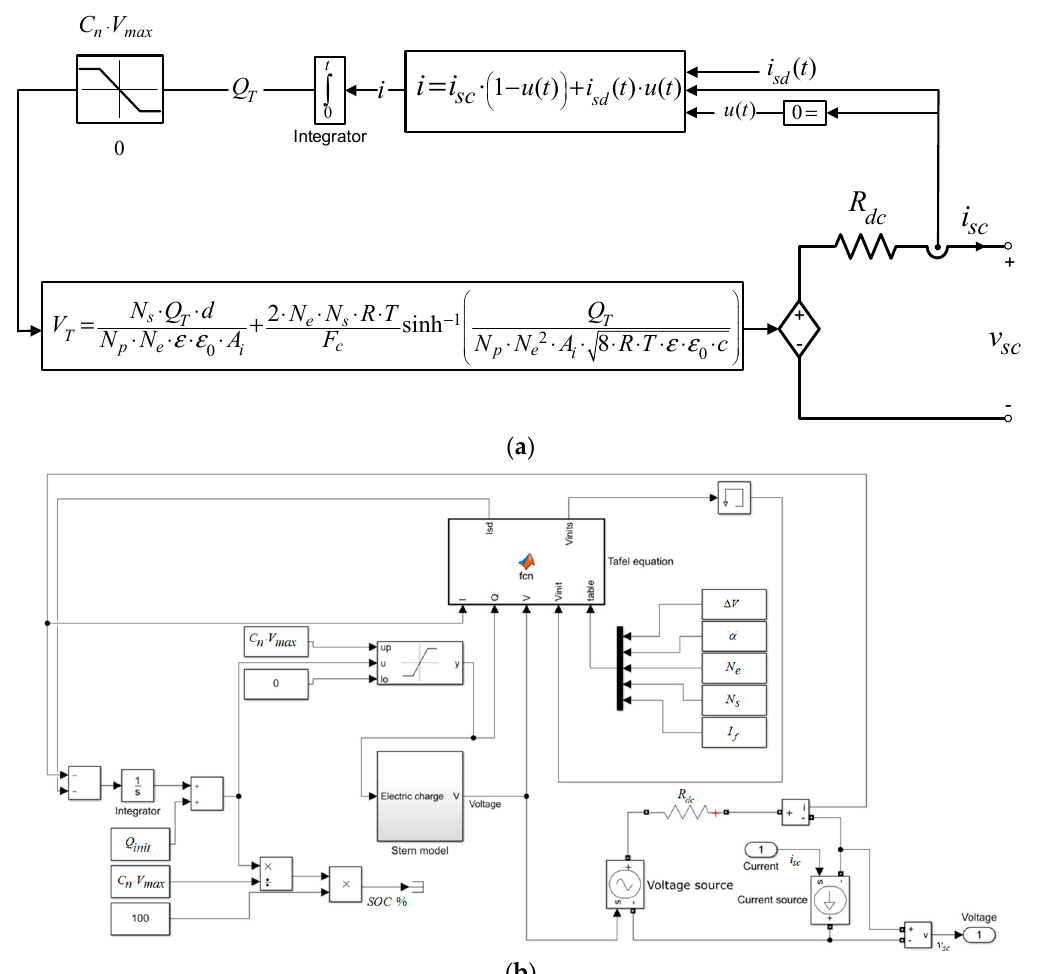
Figure 1. Stern-Tafel model: ( a ) Electric circuit; ( b ) Simulink implementation.